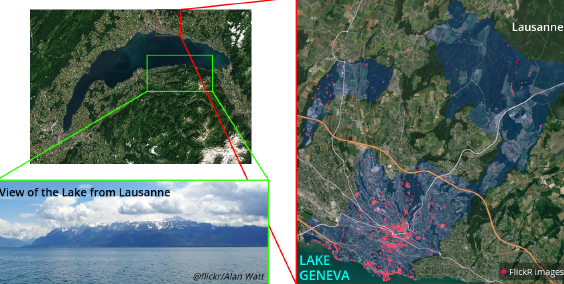
Figure 1: Cartographic representation of the city of Lausanne, the collected FlickR photograph locations are represented as pink dots on the map (right). A photo from flickR (bottom-left) illustrates the view of Lake Geneva and the Alps from the southern tip of the